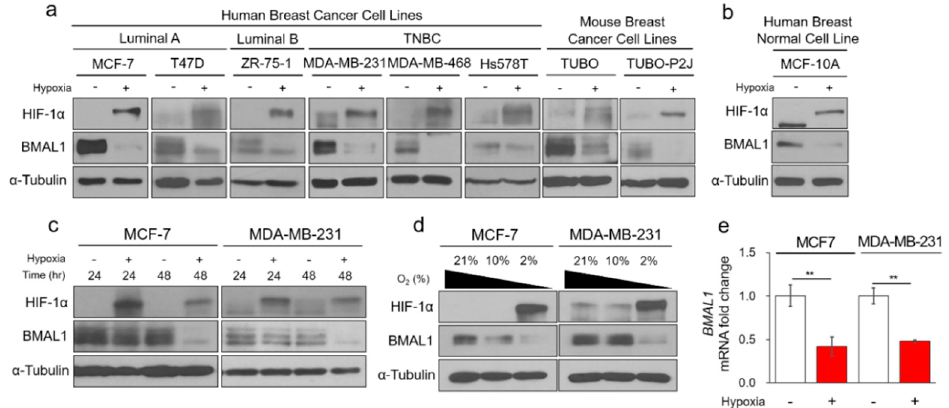
Figure 1. Chronic hypoxia reduces circadian BMAL1 expression in breast cancer cells. ( a ) Breast cancer cell lines were incubated in normoxia or 2% O 2 hypoxia for 48 h. Cell lysates were analyzed by immunoblotting. ( b ) MCF-10A was incubated in normoxia or 2% O 2 hypoxia for 48 h. Cell lysates were analyzed by immunoblotting. ( c ) MCF-7 and MDA-MB-231 were incubated in normoxia or 2% O 2 hypoxia for 24 and 48 h. Cell lysates were analyzed by immunoblotting. ( d ) MCF-7 and MDA-MB-231 were incubated in normoxia, 2% or 10% O 2 hypoxia for 48 h. Cell lysates were analyzed by immunoblotting. ( e ) MCF-7 and MDA-MB-231 were incubated in normoxia or 2% O 2 hypoxia for 48 h. Cell lysates were analyzed by RT-qPCR. Data represent the mean ± SD, n = 3. ** p < 0.01 vs. the control group by a Student’s t